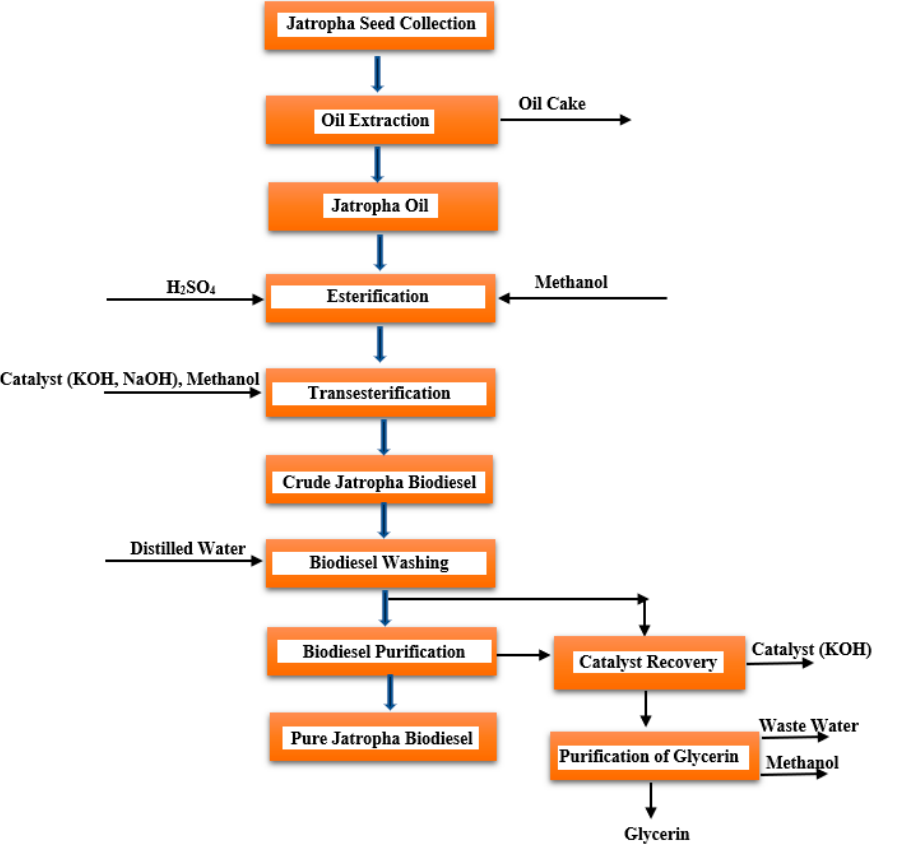
Figure 12. Process flow diagram for the synthesis of biodiesel from Jatropha seed